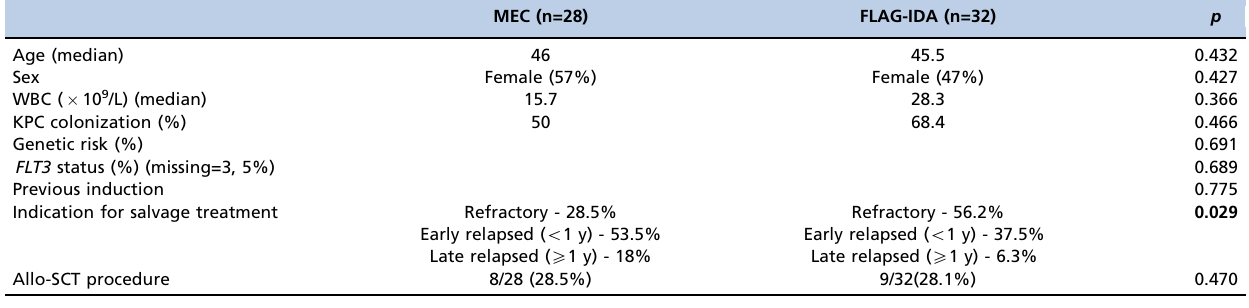
Table 2 - Comparison of baseline characteristics between the two